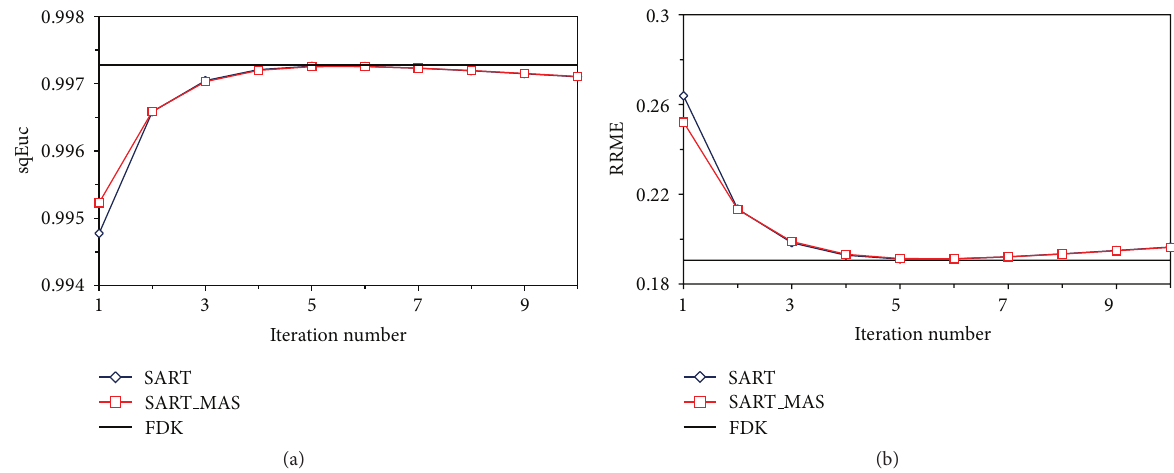
Figure 5: Comparison of convergence rates of three algebra reconstructions with (a) square Euclidean distance and (b)